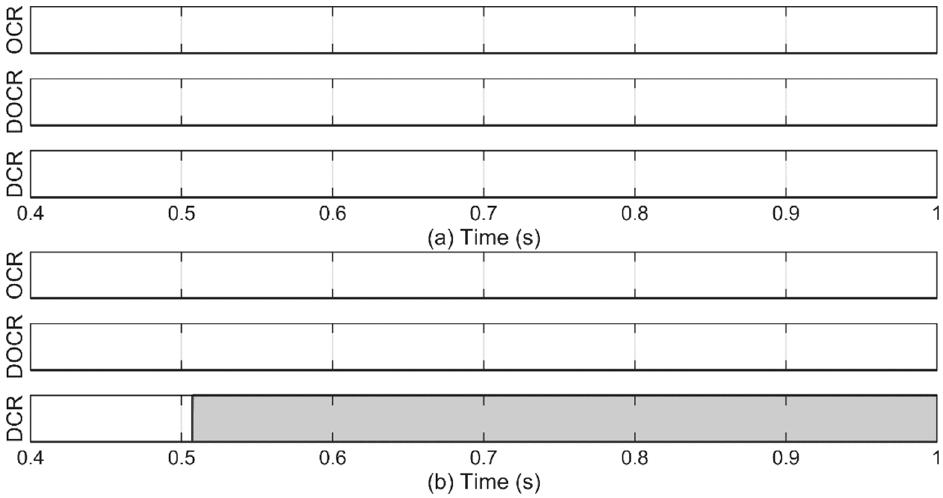
Figure 9. Tested system.